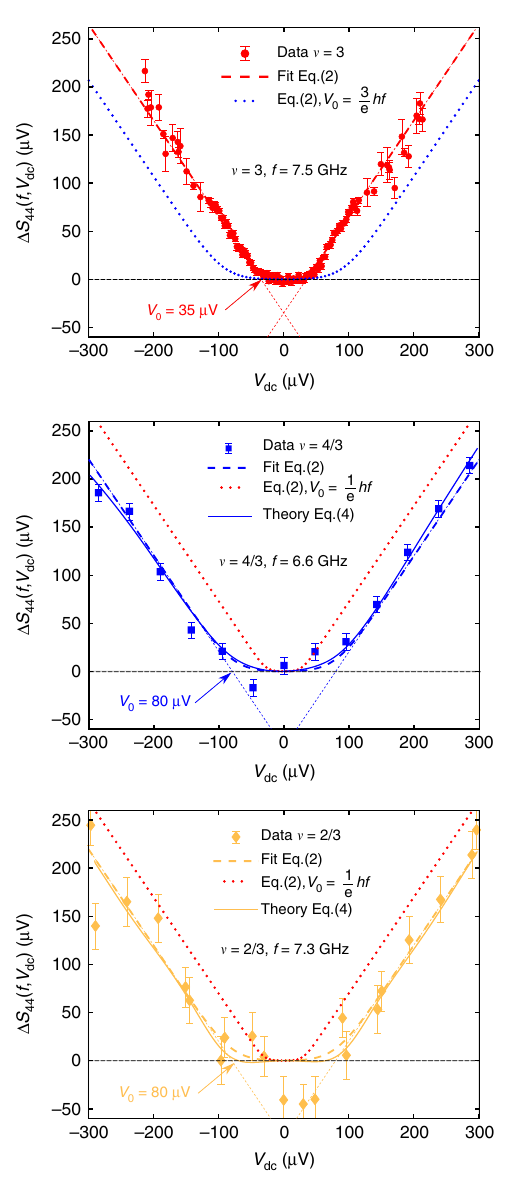
Fig. 3 High frequency noise measurements. Measurements of Δ S 44 ( f , V dc ) for the three fi lling factors at f ≈ 7 GHz. Fits by Eq. (2) with V 0 as the fi tting parameter are plotted in dashed lines. Δ S 44 is rescaled in Volts (see manuscript text). Comparisons with non-equilibrium FDR, Eq. (3), using the measurements of Δ S 44 ( f = 0, V dc ) are represented in solid lines. Finally, the dotted lines represent plots of Eq. (2) with charge q = e /3 at ν = 3 (blue dotted line) and q = e at ν = 4/3 and ν = 2/3 (red dotted line). Error bars are de fi ned as standard error of the mean